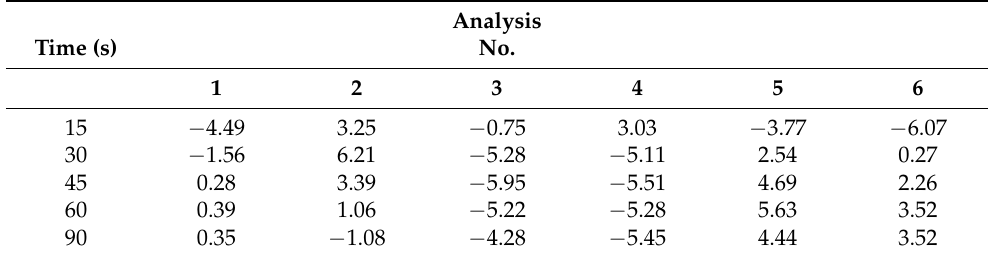
Table 2. Difference of the results of the experiment and the numerical model in percentage (%).